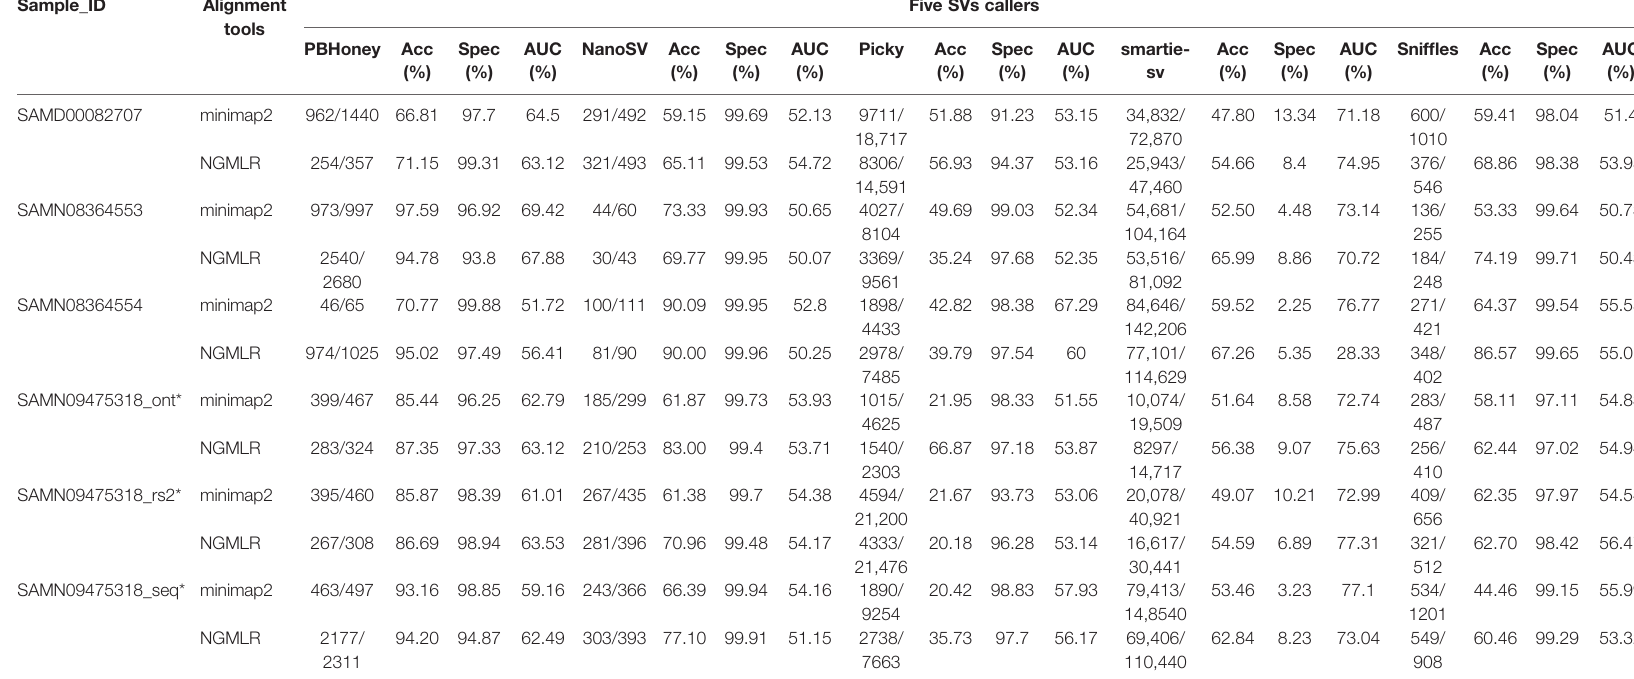
*ont, rs2, and seq presented the datasets from ONT GridION, PacBio RSII, and PacBio Sequel, respectively. Acc: the accuracy of validated SVs. Spec: the speci fi city of detecting SV by combination alignments and